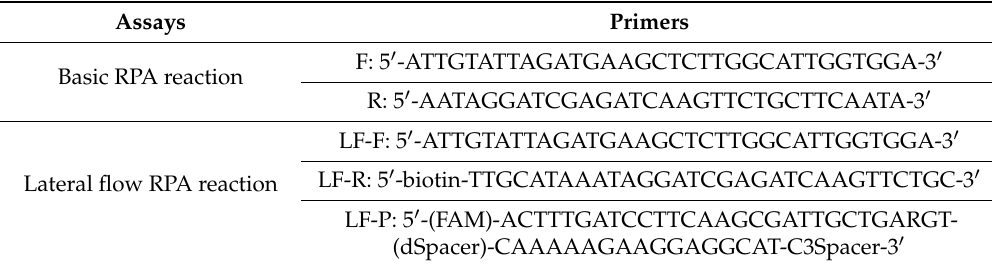
Table 2. Oligonucleotides of basic recombinase polymerase amplification (B-RPA) and LF-RPA assay used in this